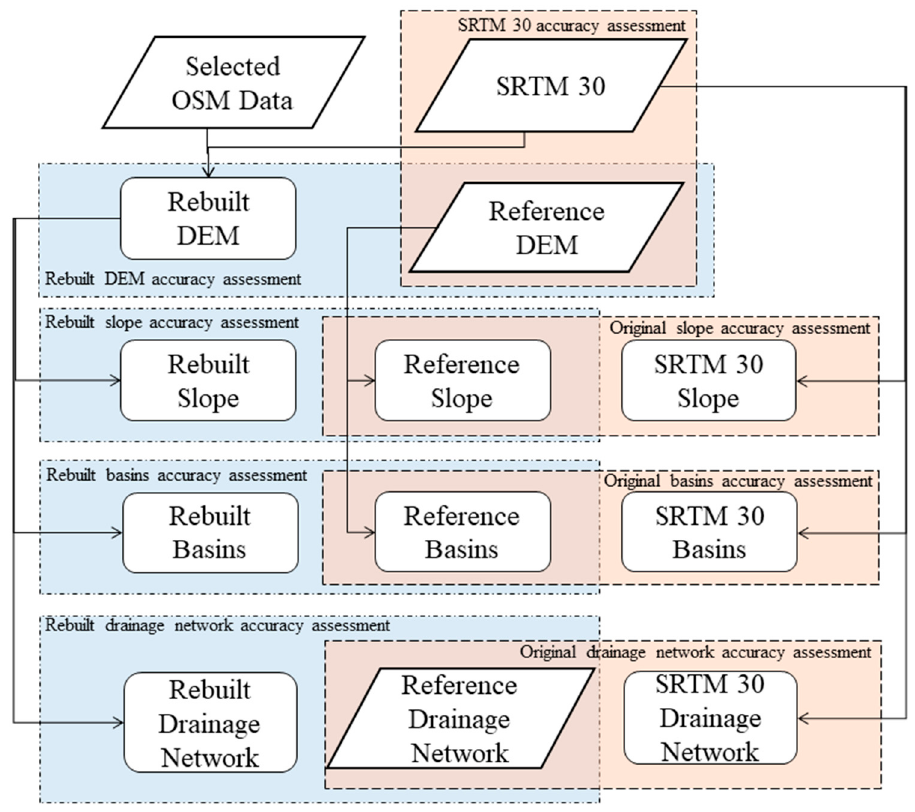
Figure 6. Flowchart of the processes to obtain the accuracy of SRTM 30 and the rebuilt DEM, as well as the accuracy of the drainage network, slopes, and basin delineation extracted from the original SRTM 30 and the DEM rebuilt using OSM data.